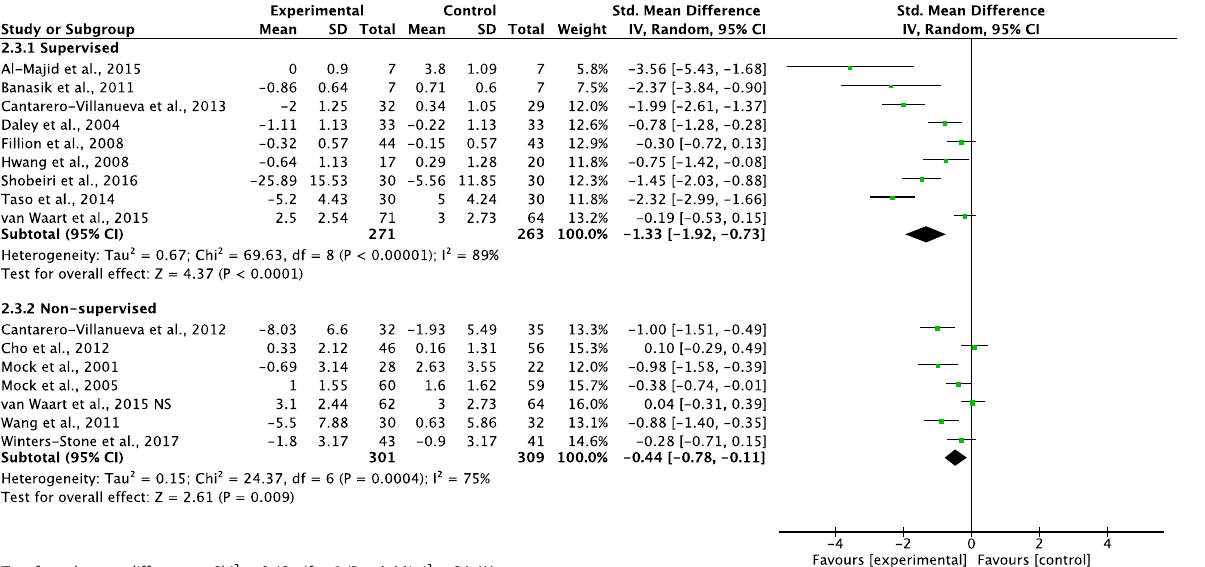
Figure 6. Meta-analyses of the effects of supervised [46,48–50,52,53,58,59,64] and non-supervised [38,40,42,49,57,59,60,62,65] exercise interventions of more than 12 weeks on CRF in BC patients. A: aerobic exercise group; COM: combination of printed materials and step pedometer; NS: non-